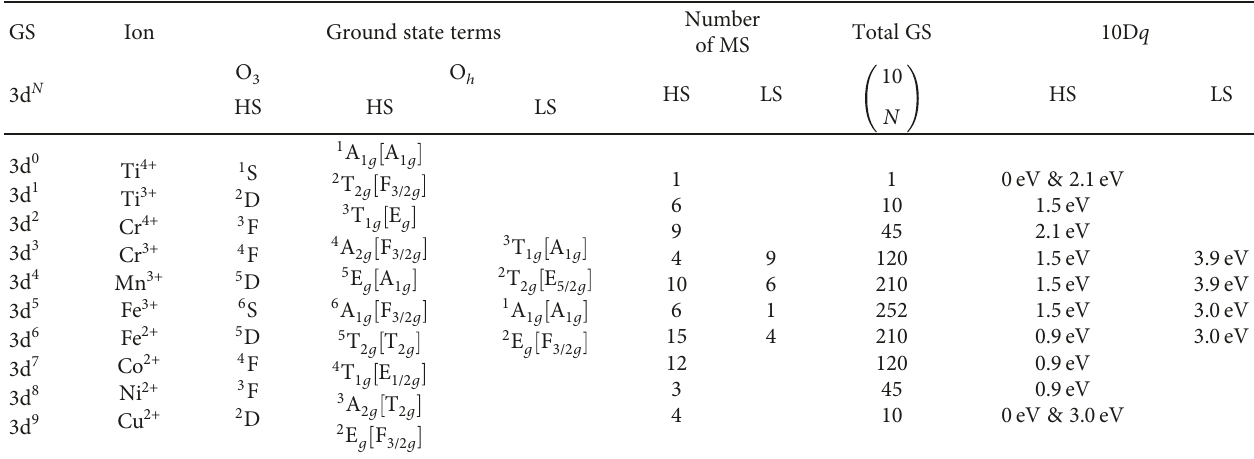
Table 7: Summary of the ground state terms, number of microstates, and crystal fi eld values (10D q ) for all ions used in our